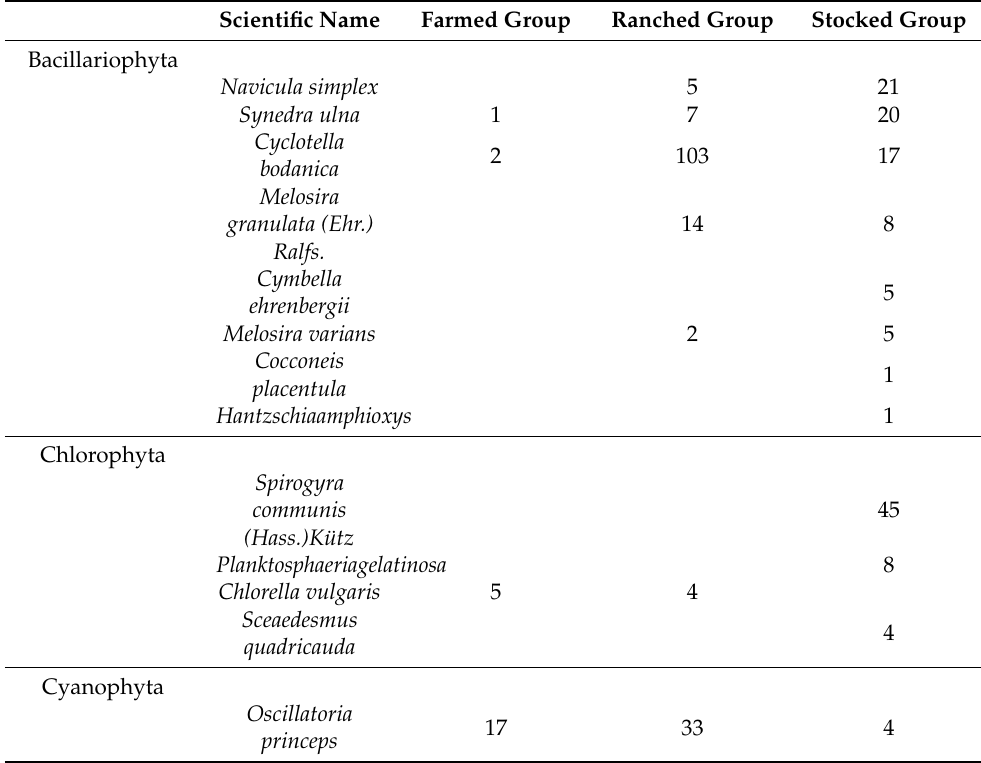
Table 7. Average density of phytoplankton of three groups